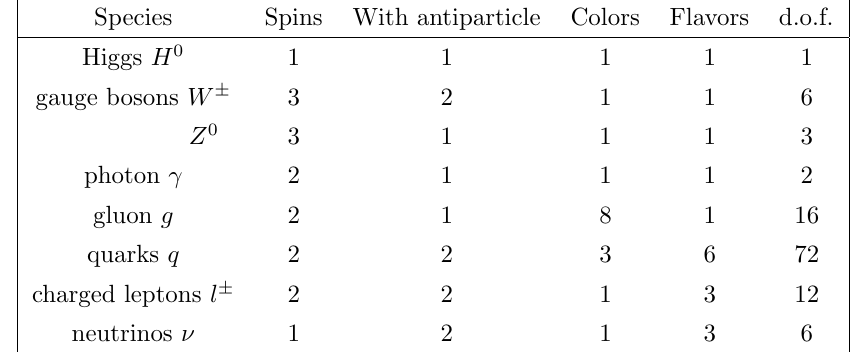
Table 1 . The degrees of freedom of all elementary particles in the